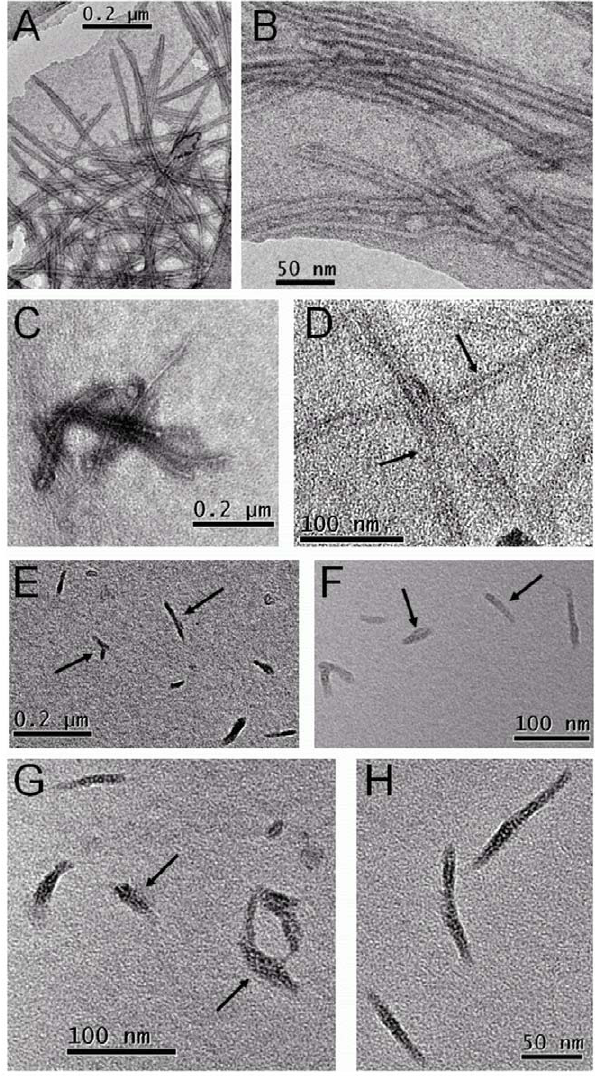
Figure 6. TEM micrographs showing the effect of the presence of 6-aminoindole or 5-hydroxindole on the aggre- gation of a -syn. Whilst both samples revealed similar kinetic data, typical of a nucleation/polymerization process, microscopy revealed contrasting data. (A and B) a -syn fibrils formed in the absence of any ligands, (C and D) a -syn fibrils formed in the presence of 5- hydroxyindole and (E–H) 6-aminoindole. Arrows indicate fibrillar structures of varying